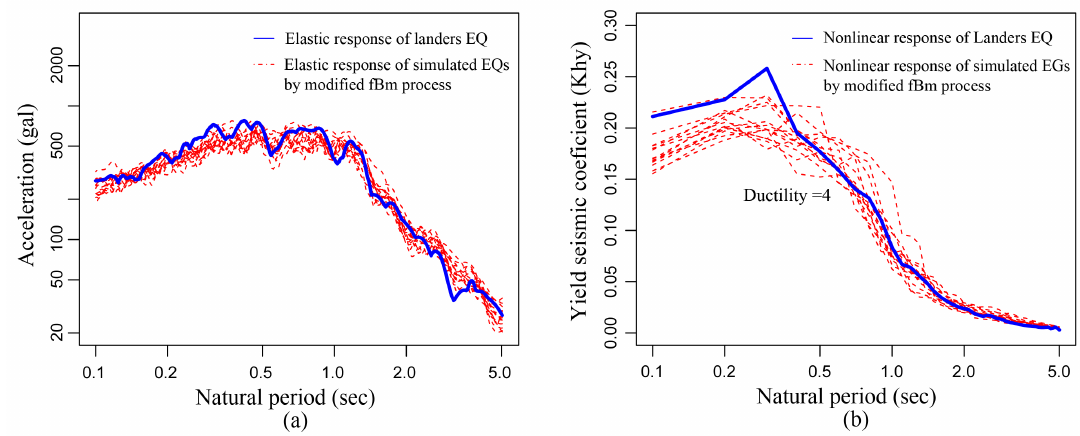
Figure 4. ( a ) Elastic and ( b ) Inelastic response spectra. Full blue line is the result obtained by using original time history and red dots line are the results obtained by using simulated time histories according to the simulated phases based on the modified fBm process.